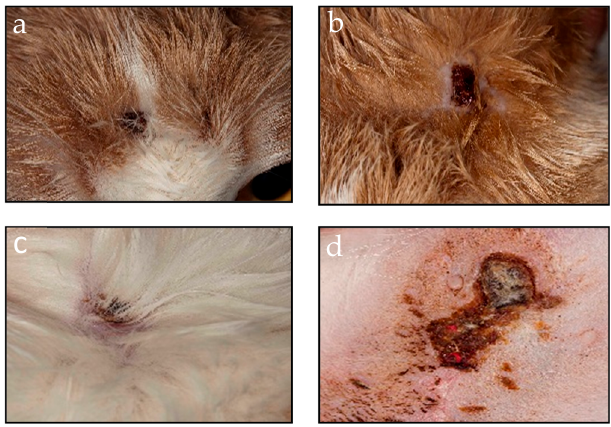
Figure 1. Clinical of the Orthopoxvirus (OPV)-infected cat. Skin lesions on the numerous vesicles